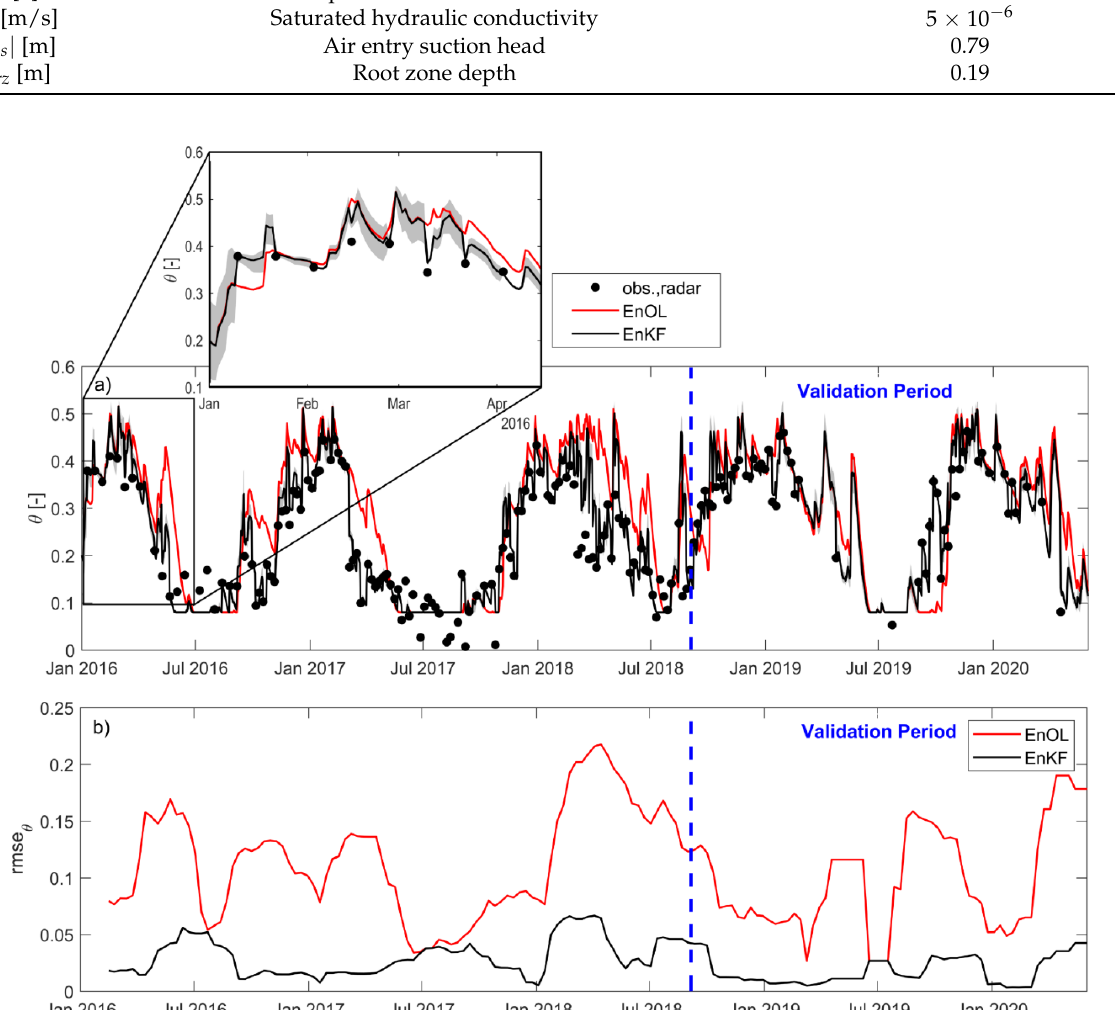
Figure 8. Soil moisture assimilation results at the grass field site: ( a ) assimilated soil moisture observations from Sentinel 1 (using DU and the proposed σ D (NDVI) relationship) (obs., radar), ensemble mean soil moisture predicted in the ensemble open loop comparison configuration (EnOL), and the ensemble mean soil moisture predicted by the assimilation approach using the Ensemble Kalman filter (EnKF) (the 95% confidence interval of the EnKF soil moisture assimilation is shown as a gray band); ( b ) the evolution of the rmse of ensemble mean soil moisture predicted by EnOL and EnKF with respect to the observed radar-based soil moisture using a 90-day window translated in 10-day